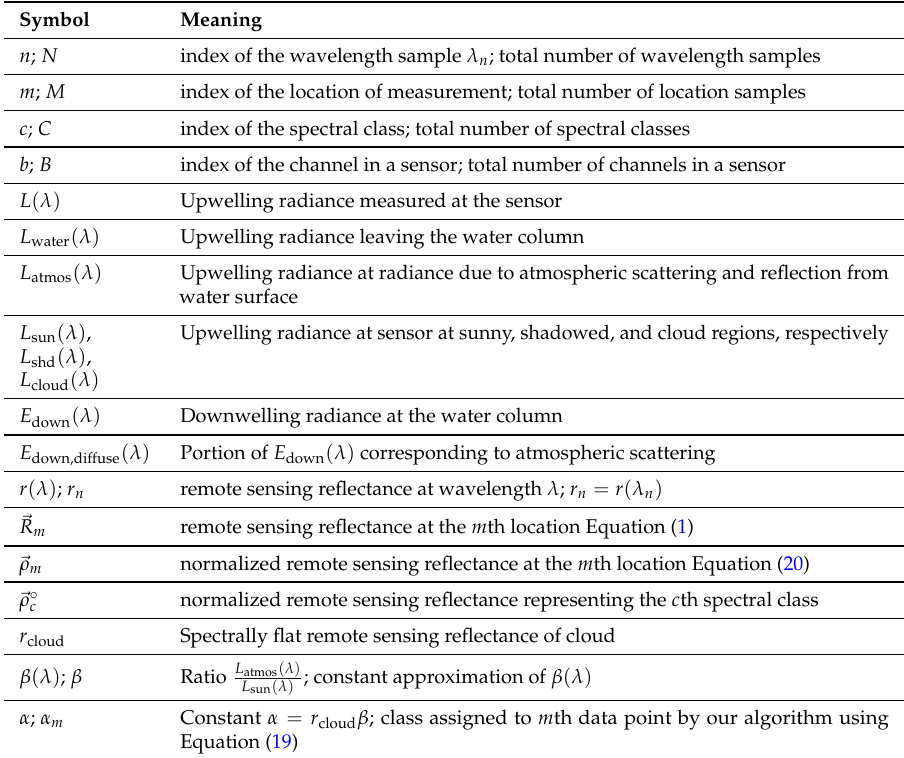
Table 2. Useful notations for our method and their meaning are presented